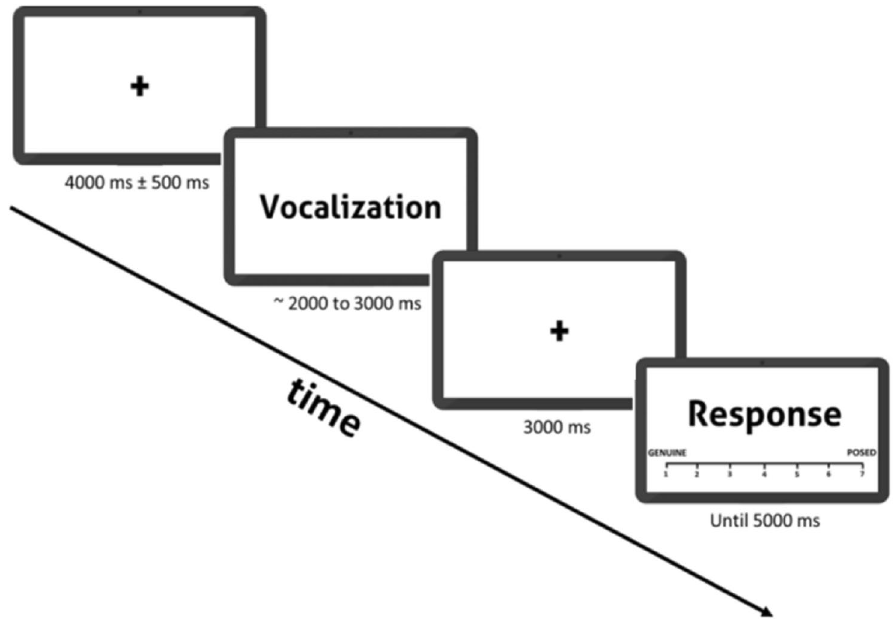
Figure 3. Outline of a single experimental trial in the authenticity